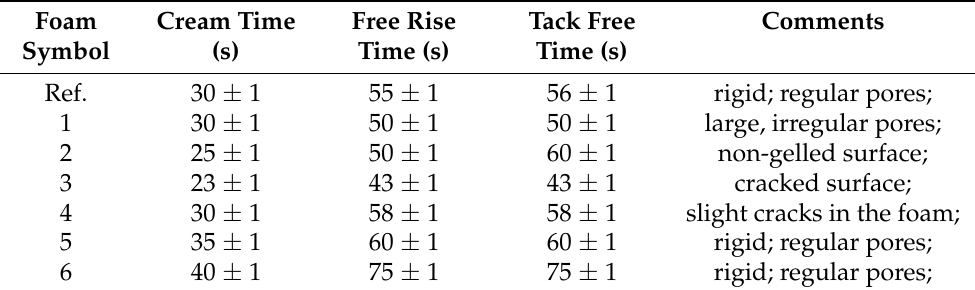
Table 2. Processing times of the obtained RPUFs and their macroscopic characteristics.